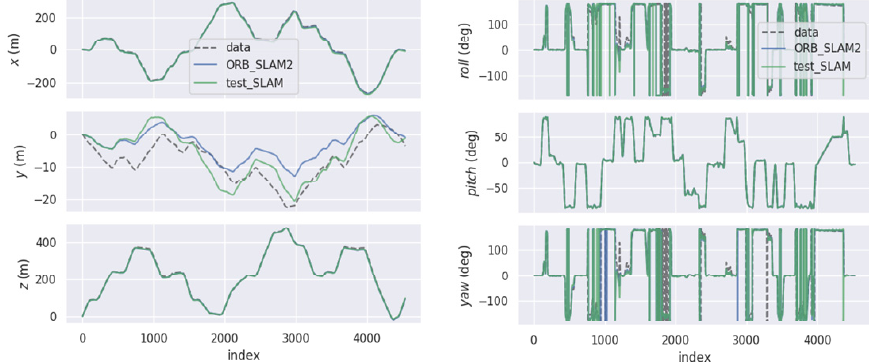
Figure 5. The comparison in space attitude of two algorithms in the KITTI dataset.